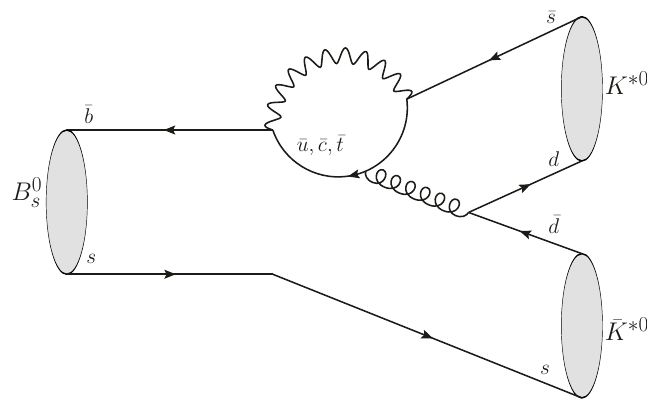
Figure 1 . Leading-order SM Feynman diagram of the B 0